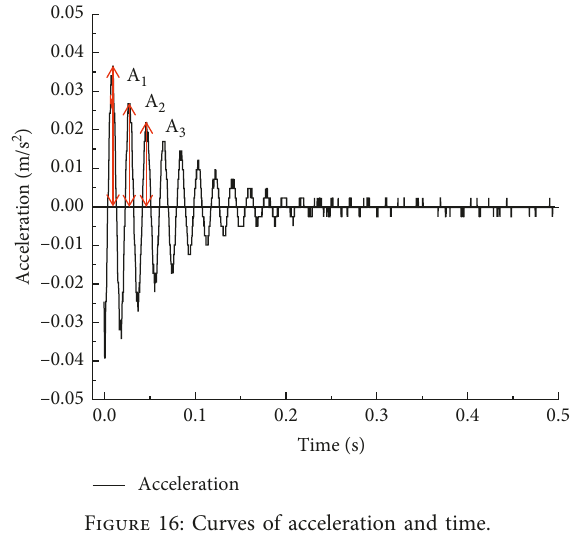
Figure 16: Curves of acceleration and time.